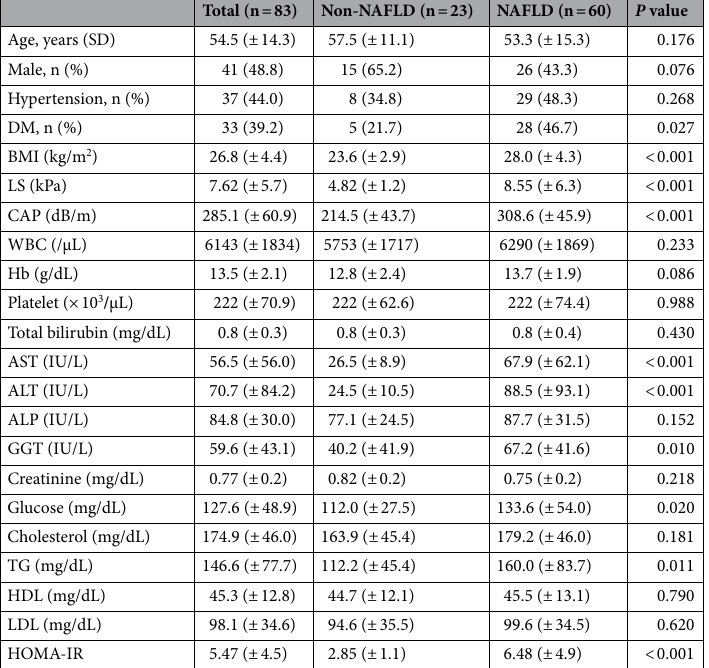
Table 1. Clinical and laboratory characteristics of study subjects. Data are expressed as mean (SD). DM diabetes mellitus, BMI body mass Index, LS liver stiffness, CAP controlled attenuation parameter, WBC white blood cell, Hb hemoglobin, AST aspartate aminotransferase, ALT alanine aminotransferase, ALP alkaline phosphatase, GGT gamma-glutamyl transferase, TG triglycerides, HDL high-density lipoprotein, LDL low- density lipoprotein, NAFLD non-alcoholic fatty liver disease, HOMA-IR homeostasis model assessment of insulin